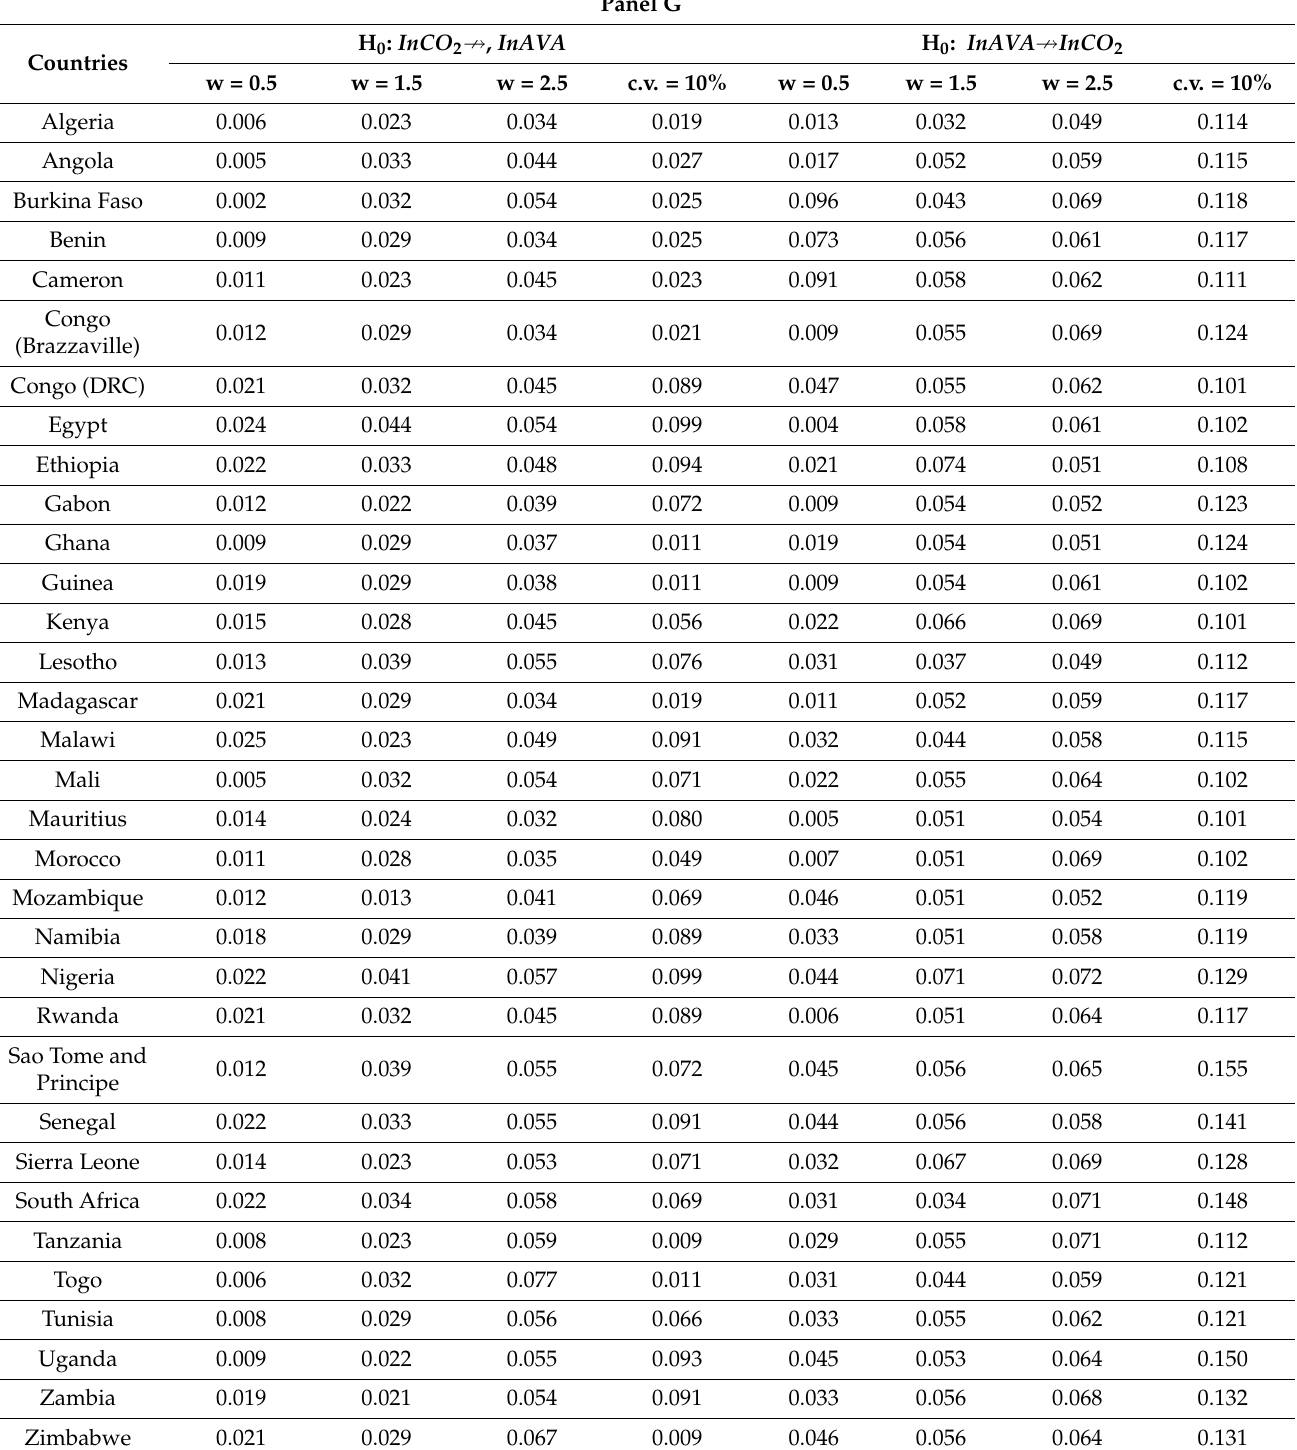
Table 10. Granger causality tests in the frequency domain estimates InCO 2 , InAVA